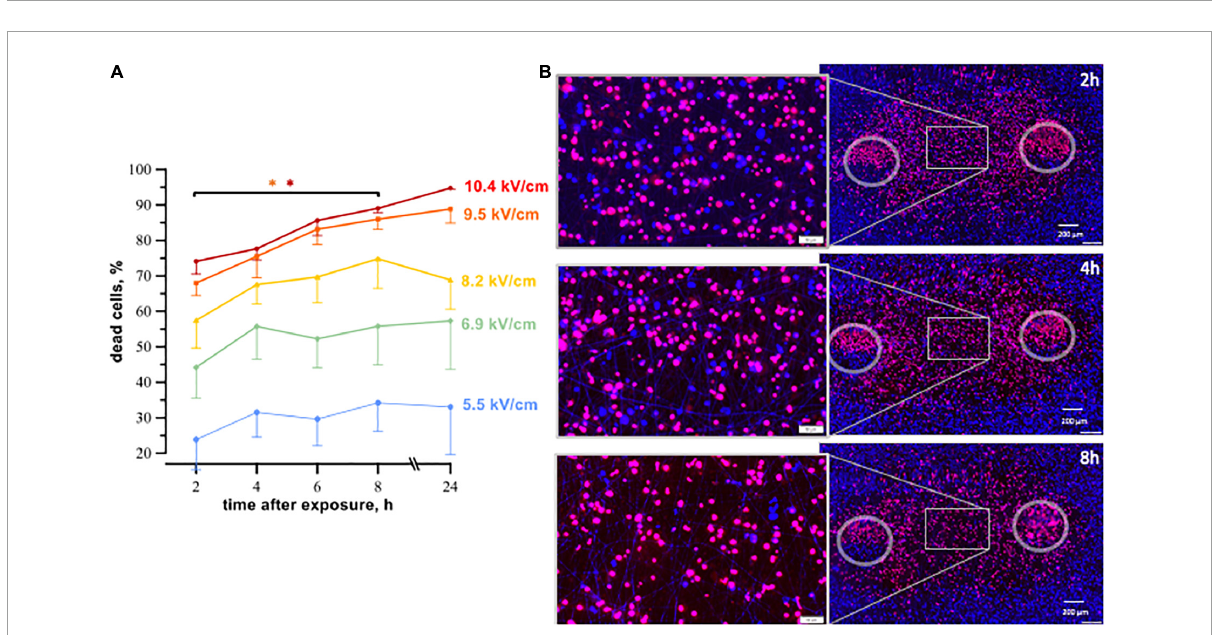
FIGURE3 The time course of cell death in human cardiomyocytes subjected to nanosecond electric shocks (200 pulses at 10 Hz, 300 ns, 1.74 kV). (A) The percentage of dead cells in the regions with different electric field strength as a function of time after nsPEF shocks exposure, mean ± SEM, 5–6 independent experiments for each time interval, * p < 0.05 for the difference in the percent of dead cells between different time intervals. Cells stained with propidium (red dye) were considered dead, while Hoechst staining (blue) marked live cells. Panel (B) represents fluorescence images of human cardiomyocytes following nsPEF shocks applied to the cell monolayer. Gray circles mark the footprints of the symmetrical electrodes. Insets show magnifications of selected areas. The cell death reached its maximum at 8 h after exposure.